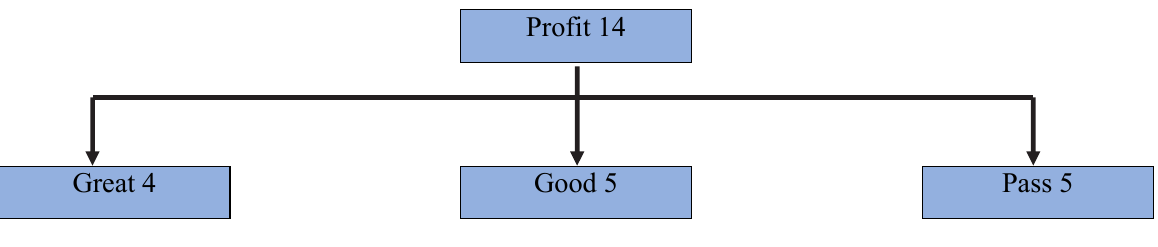
Fig. 5. Divide the sample into three sample sets with the Training Attribute Profit